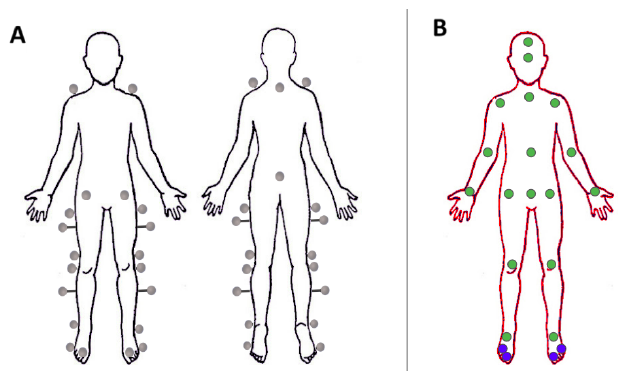
Figure 3. ( A ) Frontal and back views of the positions of the 22 markers positioned in this study according to the Davis protocol [30]. Specifically they were placed on the spinal process of C7 and on the spinal process of the sacrum (both visible in the back view) and bilaterally on: the acromion, the Anterior Superior Iliac Spine (ASIS), the greater trochanter, the middle between the greater trochanter and the lateral epicondyle of the femur (with bars 5 cm long), the lateral epicondyle of the femur, the fibula head, the middle between the fibula head and the lateral malleolus (with bars 5 cm long), the lateral malleolus, the first metatarsal phalangeal joint, and the fifth metatarsal phalangeal joint on the lateral aspect of the foot. ( B ) 2D keypoints (green and blue dots) considered in this work from the Human3.6 dataset. The two blue keypoints in each foot are highlighted because they are not included in [15] and we added them in our